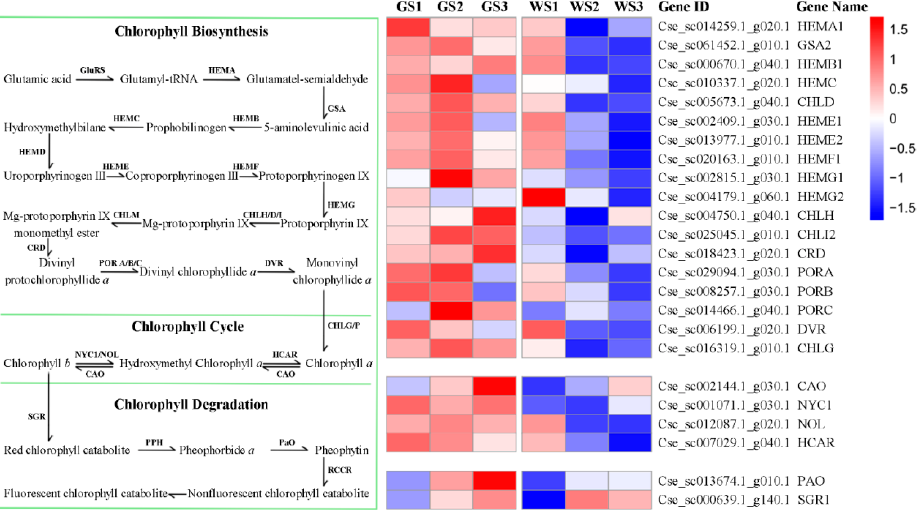
Figure 4. Expression heatmap of DEGs involved in chlorophyll metabolism in different samples.